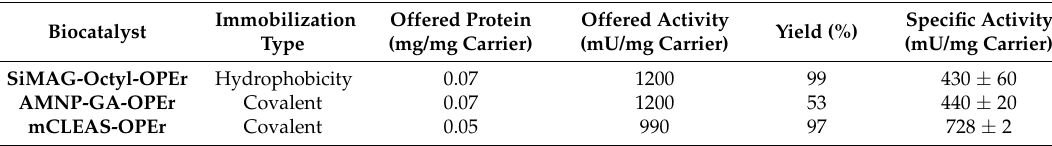
Table 1. Immobilization of OPEr onto magnetic nanoparticles. Lipase activity was determined using p NPB as the substrate. The amount of OPEr attached to the carriers was calculated subtracting the activity of the free enzyme in the supernatants before and after immobilization. The terms offered protein and offered activity refer to the amount of protein and lipase activity of the protein solution before